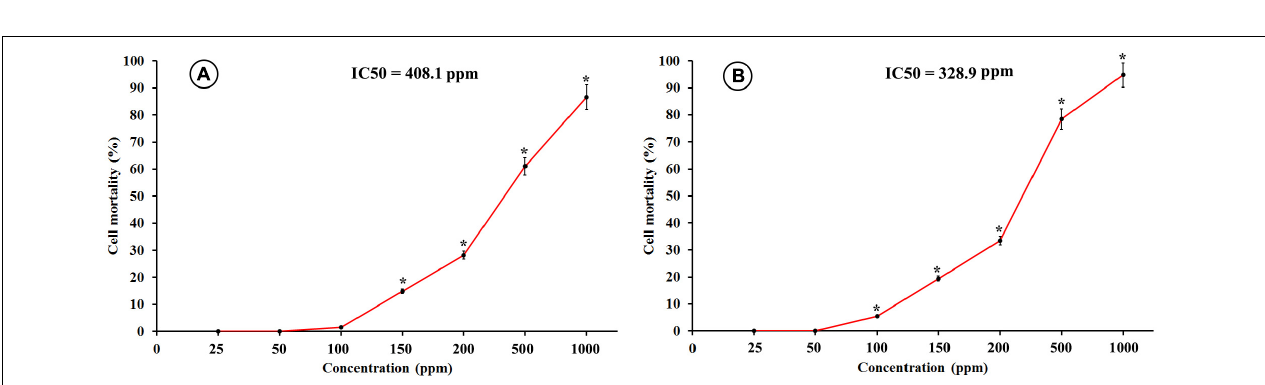
Frontiers in Plant Science |